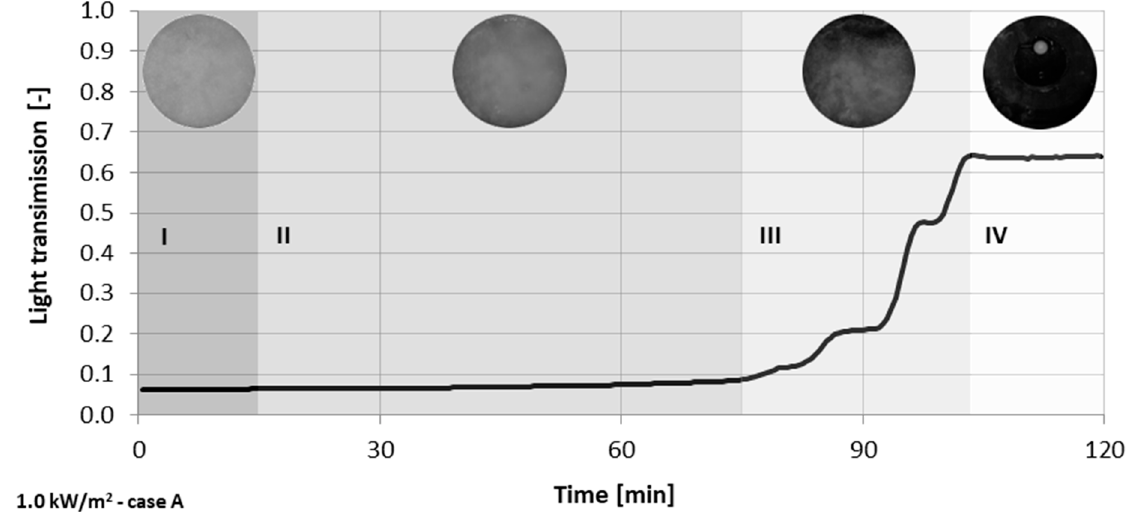
Figure 7. Direct light transmission versus time for an irradiance of 1000 W/m 2 , case A.